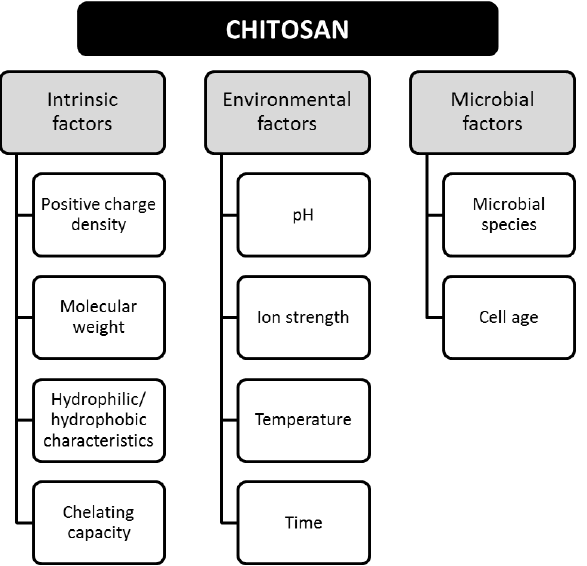
Figure 3. Factors involved in the bioactivity of chitosan. Adapted from Reference [16]. The intrinsic properties can be modified by varying the temperature and time of exposure when CS is in dispersion [16]. The antimicrobial activity is totally dependent on the pH of the medium and the solubility of CS [19]. For instance, a stronger inhibitory effect has been demonstrated at lower pH, such inhibitory effect decreases as the pH increases, and this is attributed to the neutralization of the -NH 2 groups in the alkaline medium [16,20]. CS can also act as a chelator for metal ions (e.g., nickel, zinc, cobalt, iron, magnesium, and copper) [21], and some studies promote its addition to modify the ionic strength [16], however divalent ions have been shown to attenuate the inhibitory activity of CS [22]. Regarding the antimicrobial effect of CS, Table 1 lists some of the pathogens that have been inhibited by CS. Table 1. Pathogens inhibited by the action of chitosan. Types of Pathogens